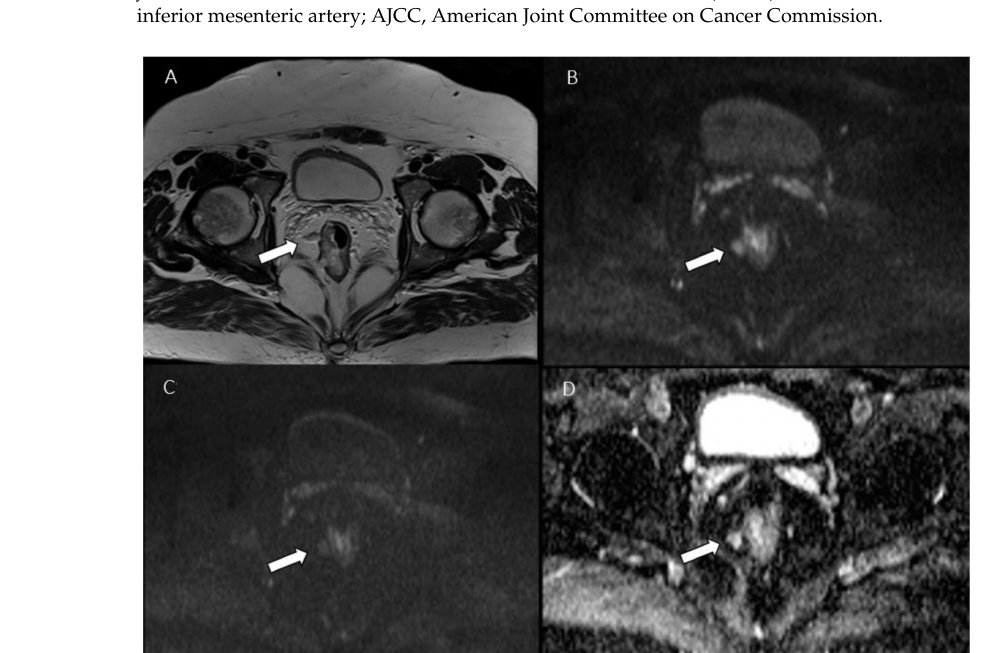
Figure 1. Man 53 y.o. with mucinous rectal cancer. Tumor deposit (arrow), assessed in T2W sequence ( A ), in b 50 s/mm 2 ( B ), in b 800 s/mm 2 ( C ) and ADC map ( D